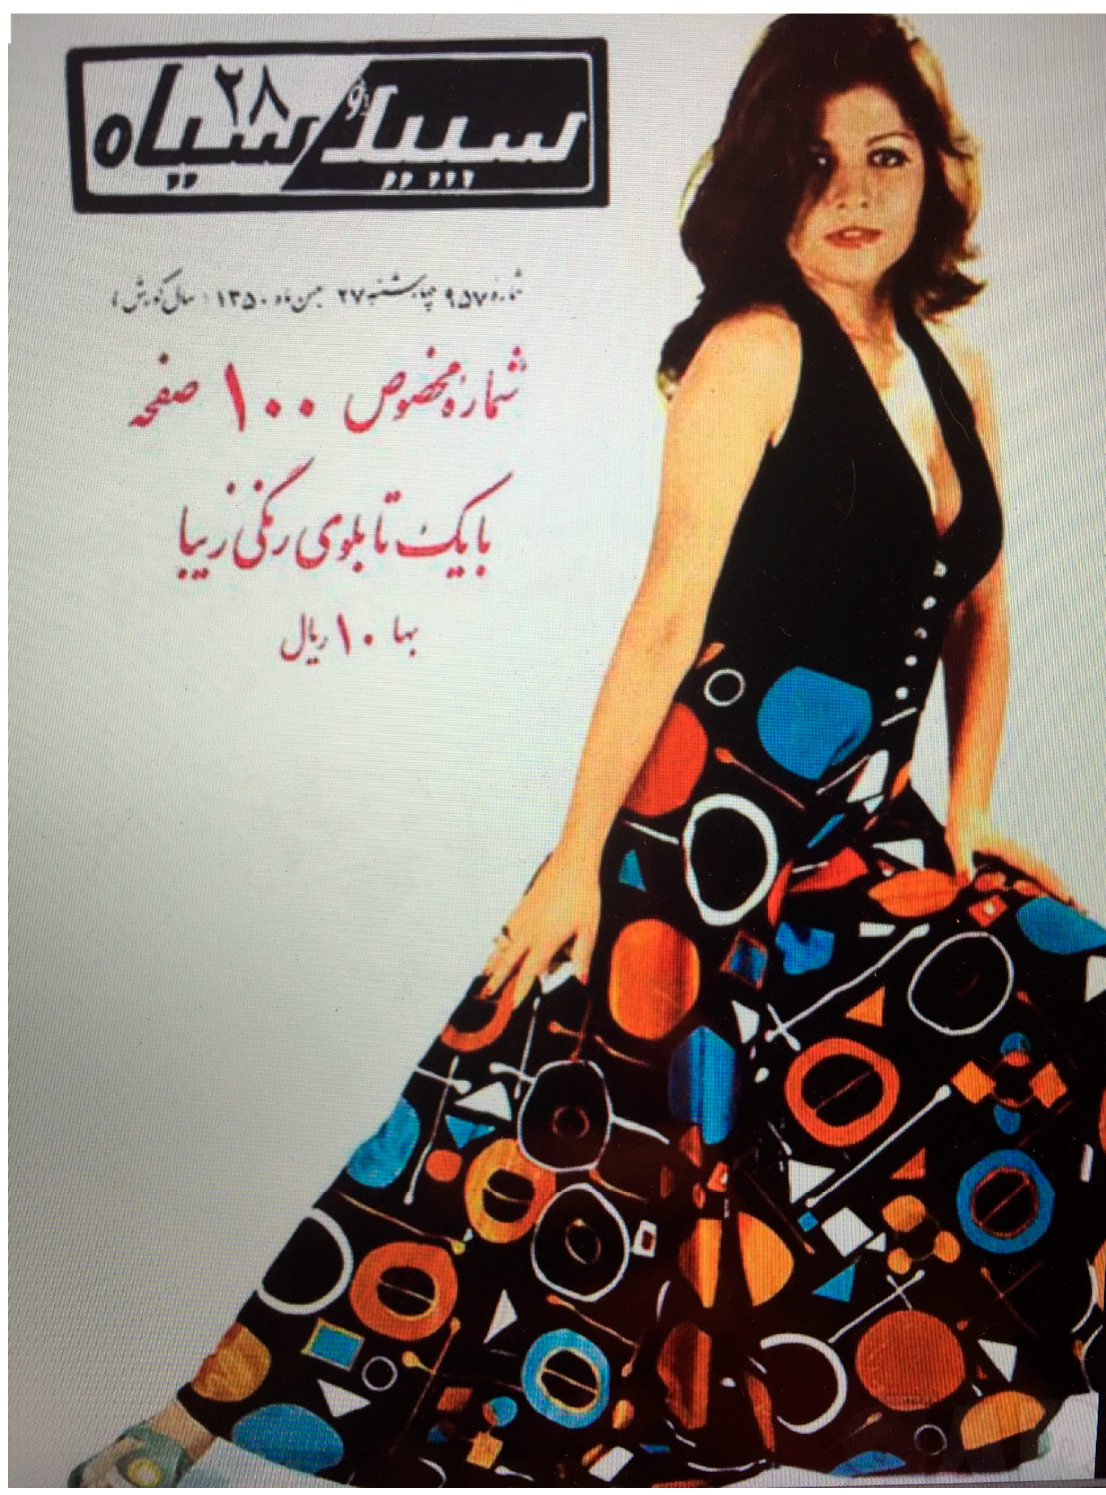
Figure 4. Cover of Sepid va Siyah (Black and White) Magazine 1970s. http://www.parstimes.com/fashion/pre_revolution/.